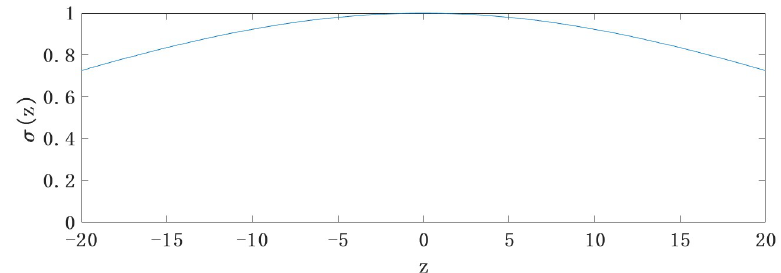
Figure 3. Gaussian distribution of 𝑧 .